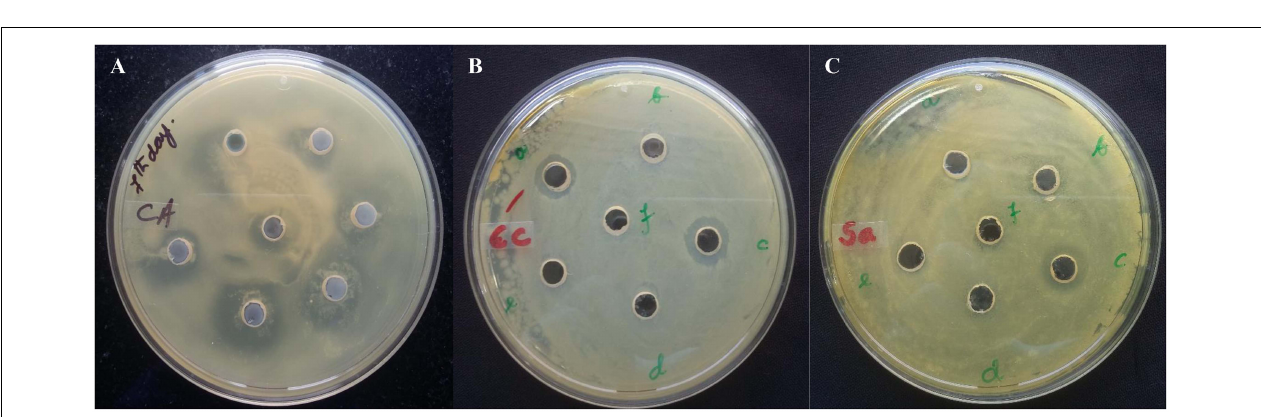
FIGURE 3 | The antimicrobial agent loaded in the well diffused in the agar medium and inhibited the growth of (A) S. aureus ATCC 25923, (B) Escherichia coli ATCC 25922, and (C) Candida albicans ATCC 20231. It has shown a broad spectrum of antimicrobial activity against gram-positive, gram-negative, and fungal pathogens.